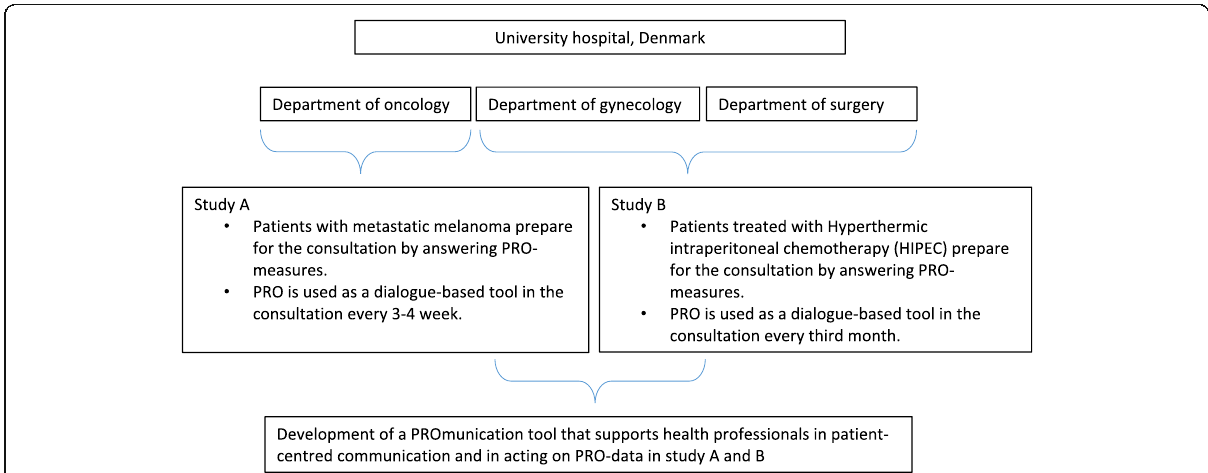
Fig. 1 An overview of the setting in which the PRO-based communication tool was